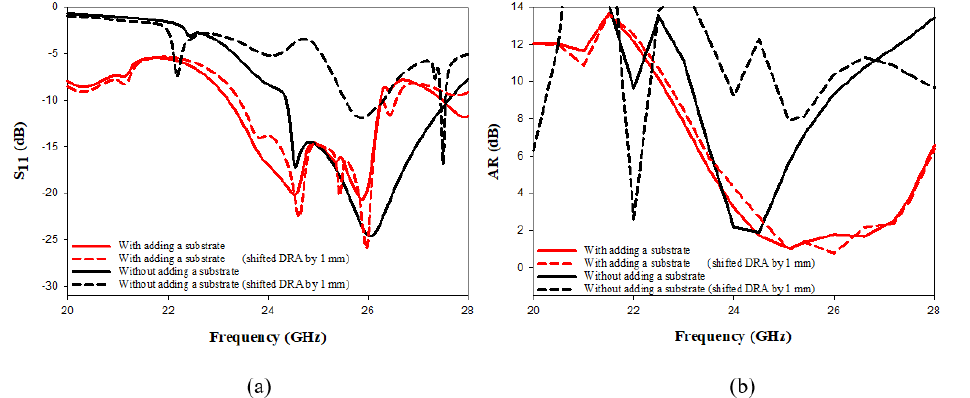
Figure 8. The impact of DRA misalignment on the performance with/without adding the additional substrate ( a ) reflection coefficient ( b ) axial